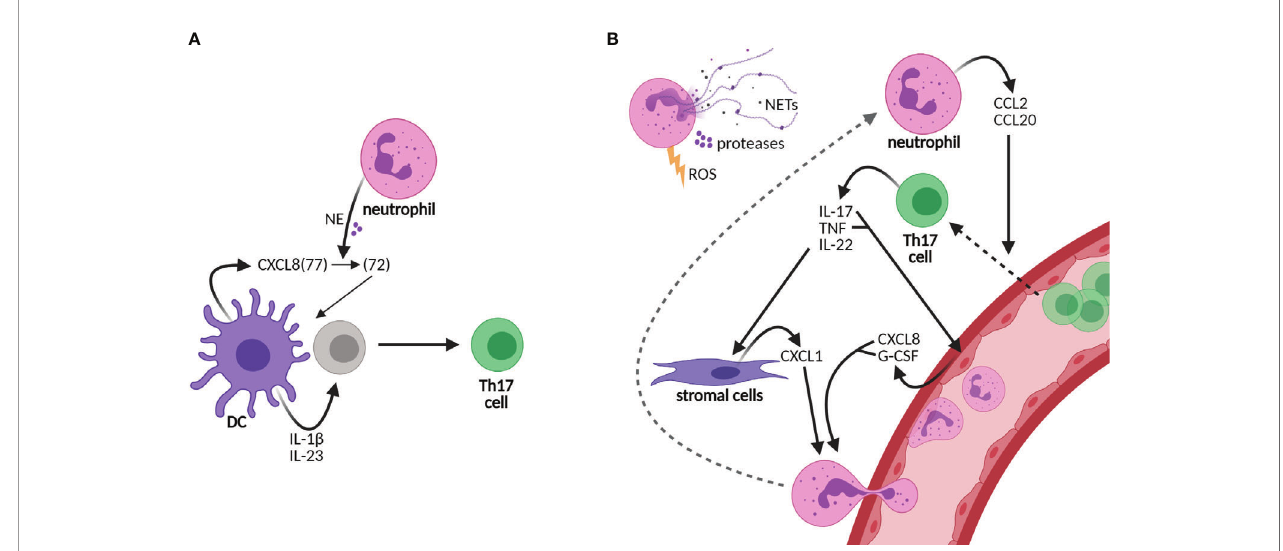
FIGURE 1 | Neutrophils sustain an in fl ammatory loop of Th17 cell development and recruitment to tissues. (A) Neutrophils shape the adaptive immunity by in fl uencing dendritic cell (DC)-driven T-cell development, e.g., Th17 cell development by cutting DC-derived CXCL8(72) into the short form CXCL8(72), which is required for Th17 cell development from human naive CD4 T cells. Other cytokines required for Th17 cell development are IL-1 b and IL-23. (B) Neutrophils are recruited to tissues via granulocyte colony-stimulating factor (G-CSF) and the chemokines CXCL1 and CXCL8, among others, of which production is promoted by Th17 cells. CXCL8 and G-CSF are produced by epithelial cells upon stimulation by IL-17 and/or tumor necrosis factor (TNF), while CXCL1 is released from stromal cells upon IL-22 stimulation. In turn, neutrophils produce CCL2 and CCL20, ligands for receptors CCR2 and CCR6, respectively, on Th17 cells, thereby elevating the in fi ltration of Th17 cells in tissues. Furthermore, neutrophils contribute to tissue damage via their release of neutrophil extracellular traps (NETs), proteases, and reactive oxygen species (ROS). Neutrophils contribute to both the development of Th17 cells in lymph nodes and the perpetuation of in fl ammation in tissues via the recruitment of Th17